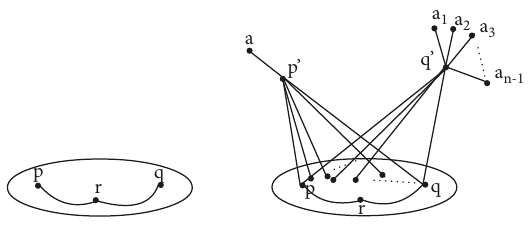
Figure vertices are contained in G [ S ] , one of the vertex, say, c must be adjacent to both a and b . Therefore, only a − b fixed